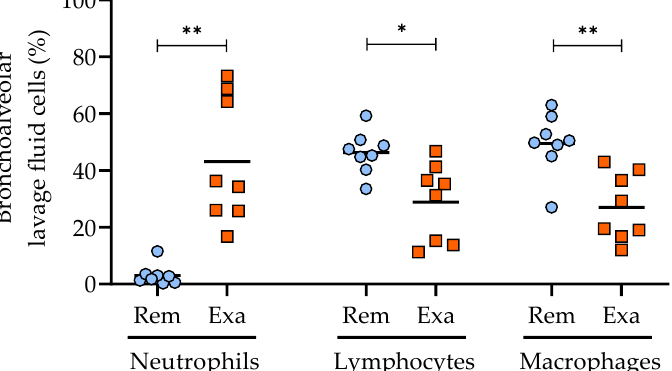
Figure 2. Percentages of inflammatory cells in the bronchoalveolar lavage fluid cytology of horses during remission (Rem) and exacerbation (Exa) of severe equine asthma (dot plot with mean). * p < 0.05, ** p < 0.01 with paired T-tests or Wilcoxon tests.